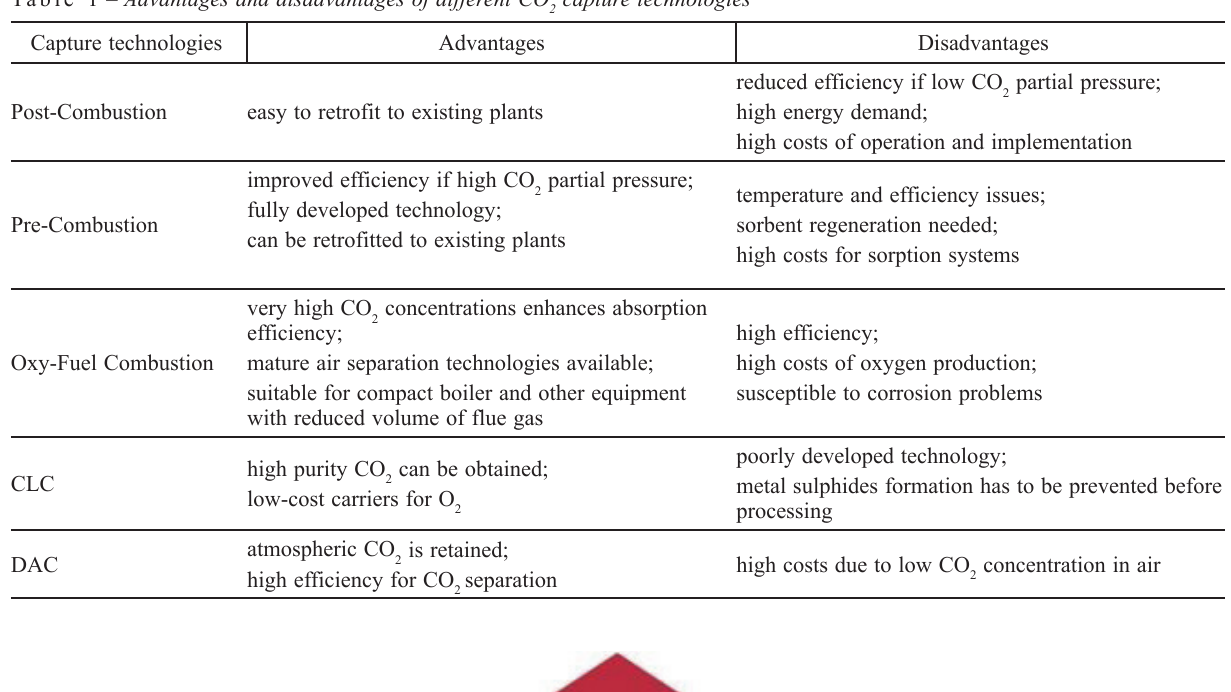
Table 1 – Advantages and disadvantages of different CO